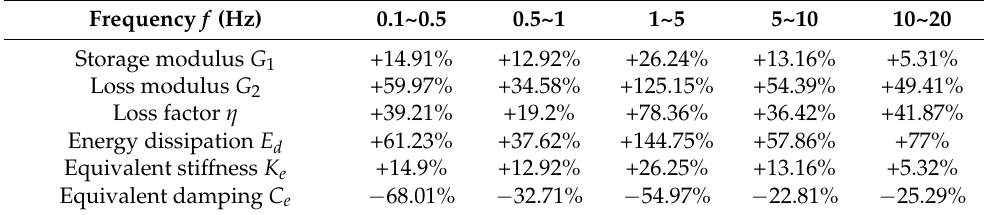
Figure 6. Dynamic properties parameters with varying displacement amplitudes. ( a ) Storage mod- ulus. ( b ) Loss modulus. ( c ) Loss factor. ( d ) Energy dissipation. ( e ) Equivalent stiffness. ( f ) Equivalent damping. Table 4. Parameters’ changing rate with different frequencies when d = 0.5